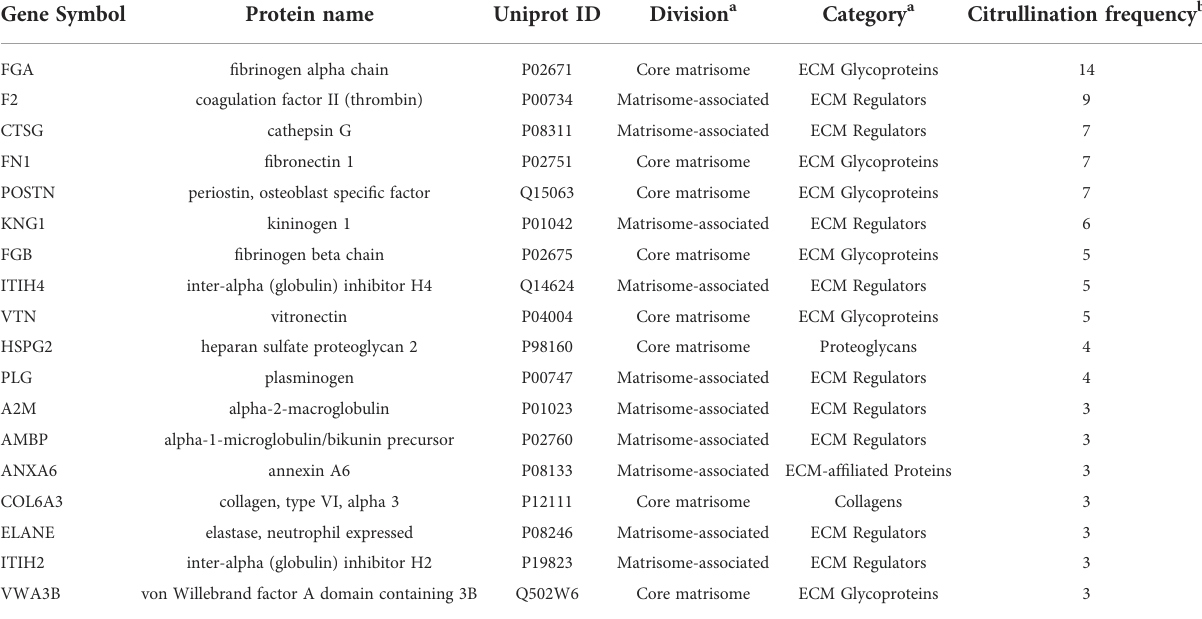
TABLE 2 Most frequently citrullinated matrisome proteins.